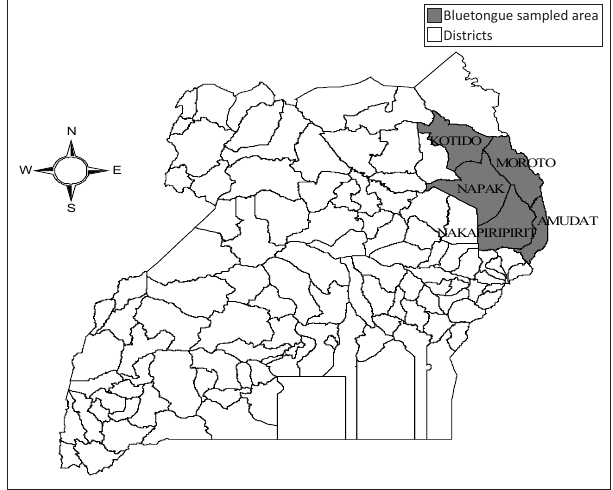
FIGURE 1: A map of Uganda showing the Karamoja sub region and bluetongue sample area.